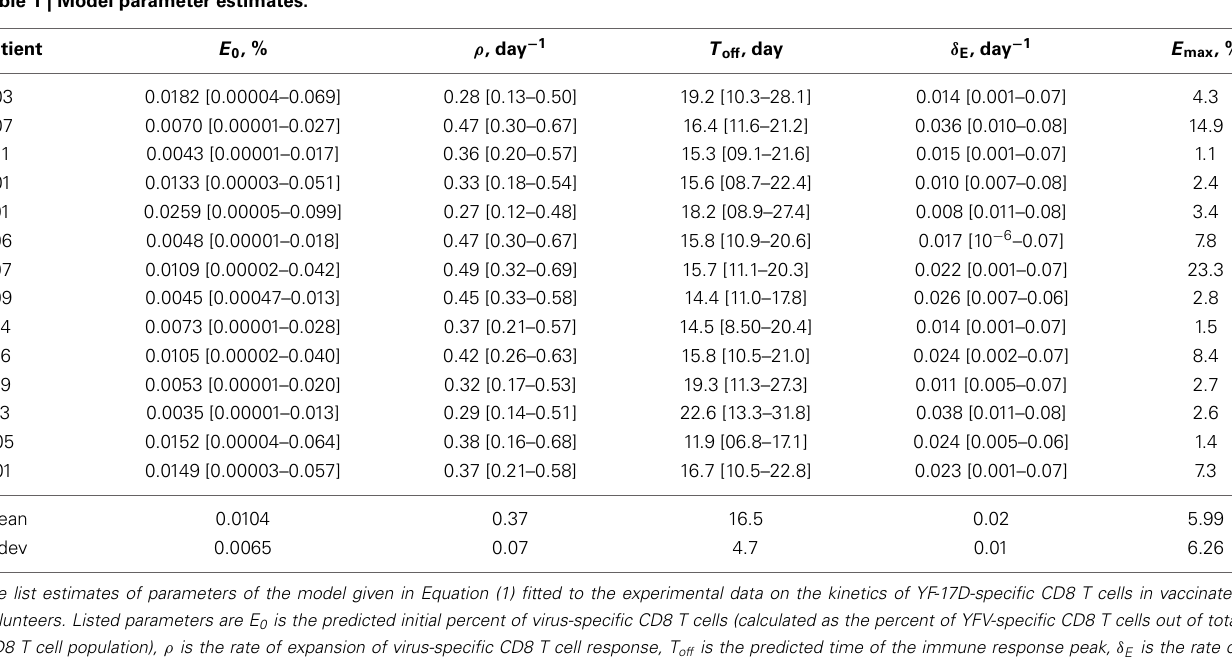
Table 1 | Model parameter